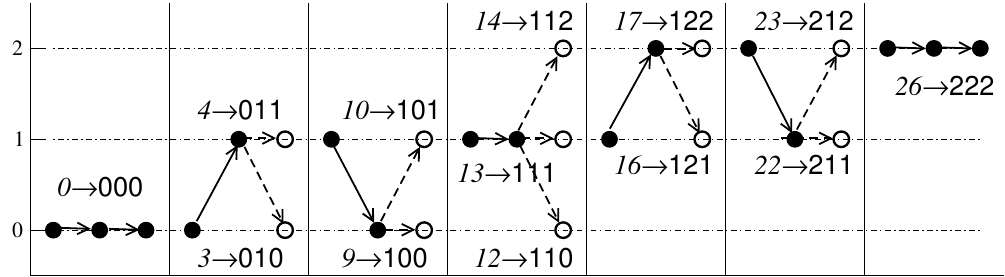
Figure 7. Representative soft transitions in symbol sequences for n = 3 and L = 3. Decimal sequence codes are shown in each case. This notation will be used in subsequent